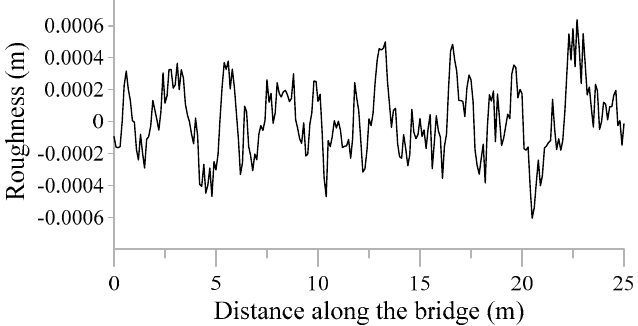
Figure 3. A typical profile of road surface roughness.